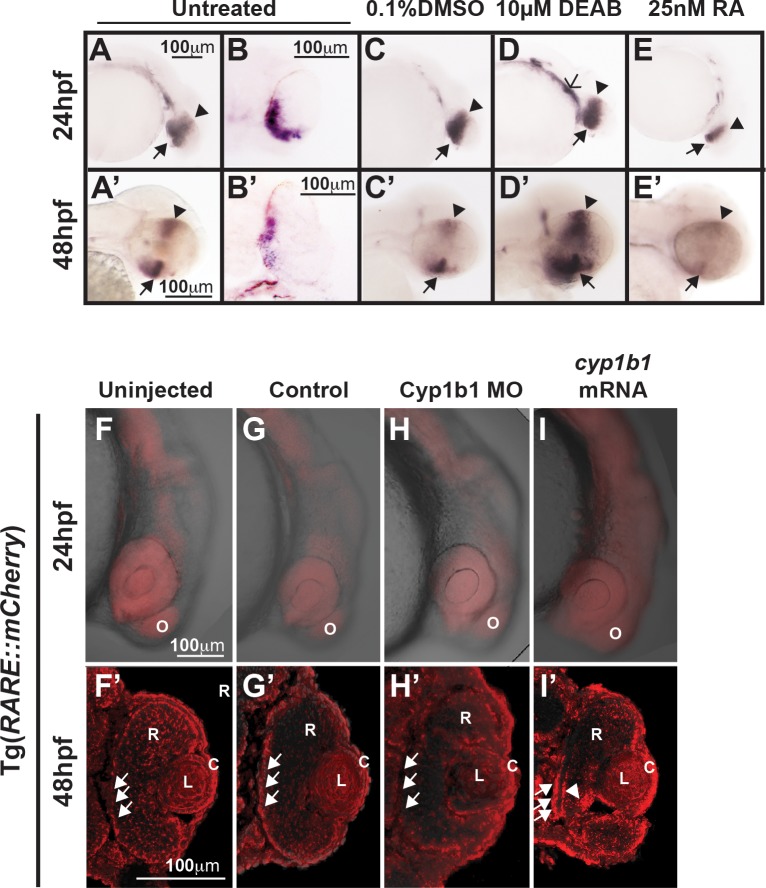
Cyp1b1 expression in the developing eye was regulated through RA. Whole-mount in situ hybridization showed cyp1b1 expression along the dorsal (arrowheads)–ventral (arrows) axis in the developing eye at 24 and 48 hpf in uninjected (A, A') and 0.1% DMSO-treated (C, C') embryos. In sections, cyp1b1 localized to the retina and retinal pigment epithelium (B, B'). Treatment with 10 μM DEAB at 12 hpf increased cyp1b1 expression in the ventral neural crest, which subsequently forms the brachial arches (D, open arrowhead) at 24 hpf and the dorsal (arrowheads) and ventral (arrows) eye at 48 hpf (D'). Exogenous treatment with 25 nM all-trans RA at 12 hpf decreased cyp1b1 expression in the dorsal and ventral eye at 24 (E) and 48 hpf (E'). Live imaging of the Tg(RARE:mCherry) reporter line showed areas of high RA activity in the eye and olfactory placode (O) in uninjected (F) and control-injected (G) embryos. Within the eye (F', G'), RA activity was observed in the retinal pigment epithelium (arrows), retina (R), lens (L), and cornea (C). MO knockdown of Cyp1b1 (H, H') showed decreased RA activity in the medial retinal pigment epithelium (arrows) correlated with the area of cyp1b1 expression (B'). Overexpression of cyp1b1 through mRNA injection diffusely increased mCherry expression at 24 hpf throughout the craniofacial region (I). Increased RA activity in the eye was also observed in the medial retinal pigment epithelium (arrows) and ocular fissure (arrowhead).